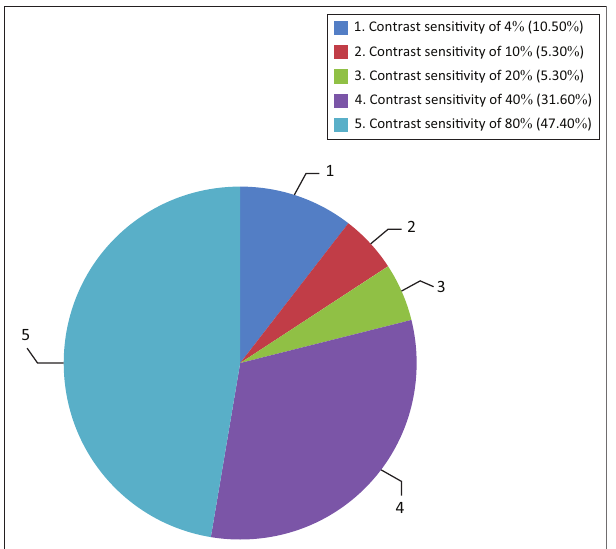
FIGURE 4: Contrast sensitivity recorded as an inverse of the contrast threshold.